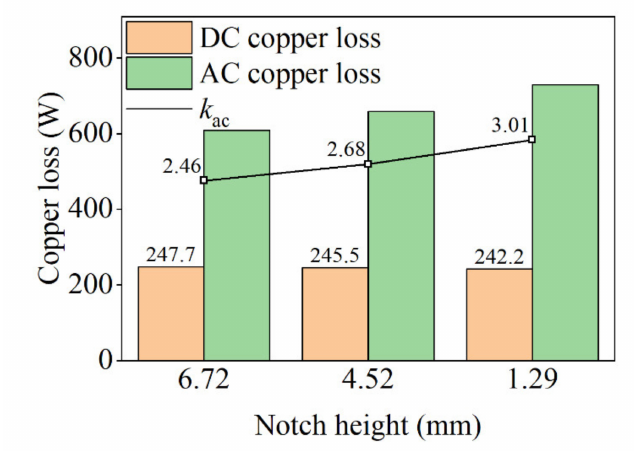
Figure 21. Copper loss and AC/DC copper loss ratio k ac with notch height at 1000 Hz.